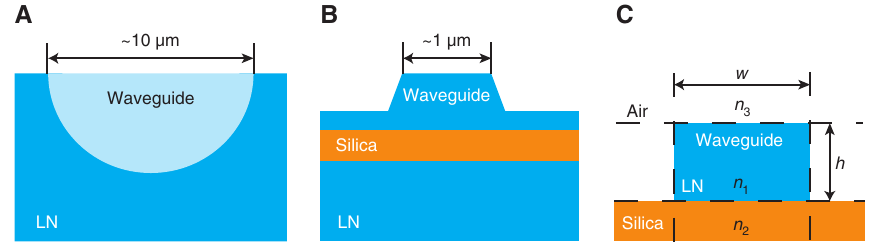
Figure 2: Schematic cross-section view of integrated LN waveguide. (A) Conventional LN waveguide; (B) LNOI ridge waveguide; (C) ideal LNOI